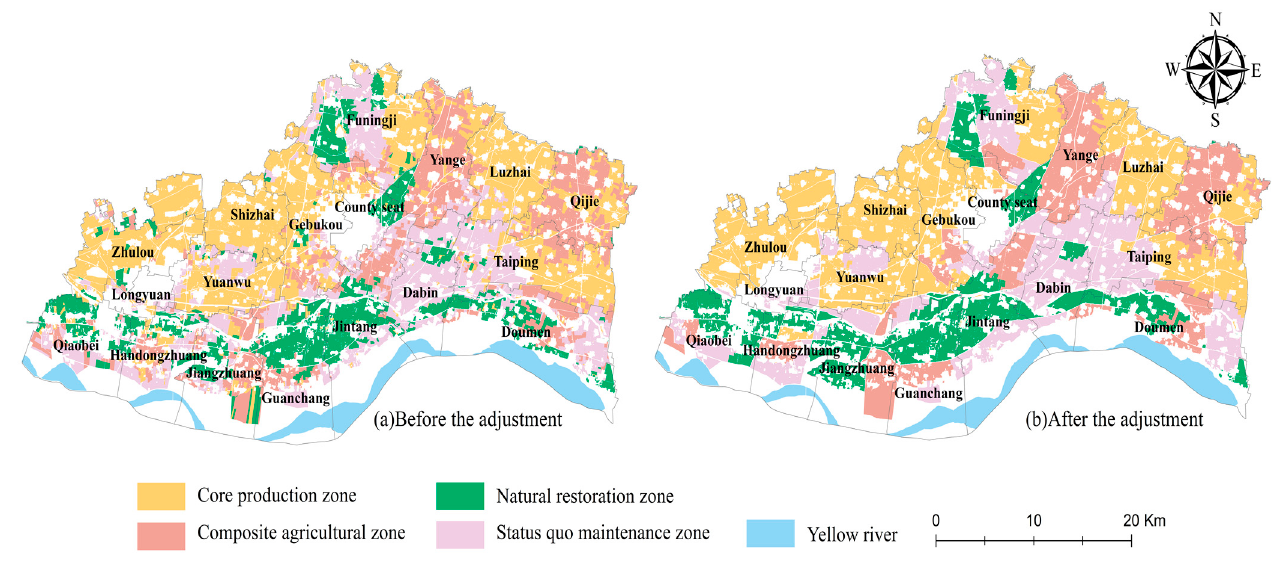
Figure 8. Zoning map for the adjustment of cultivated land use in Yuanyang County: ( a ) before the adjustment; ( b ) after the adjustment.